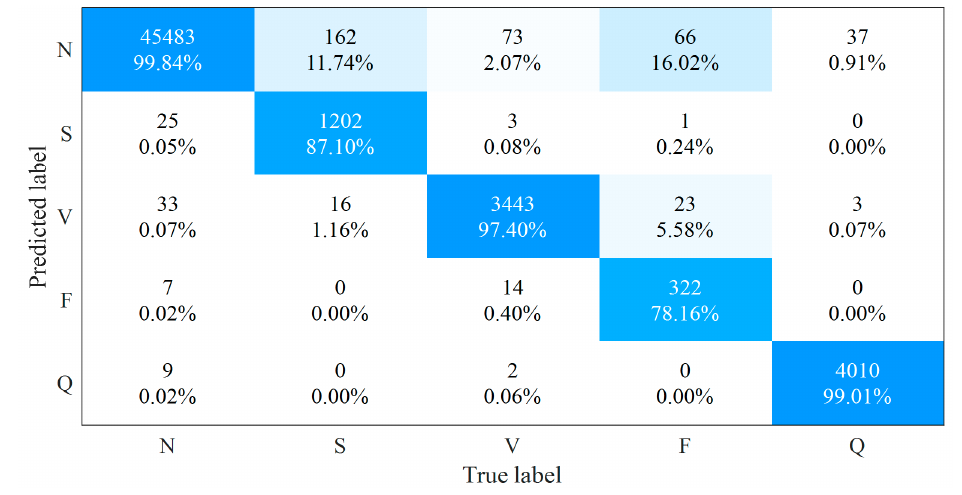
Figure 5. The confusion matrix of the proposed method on the MITDB. Table 7. The performance comparison with the state-of-the-art methods on the MITDB Ref.